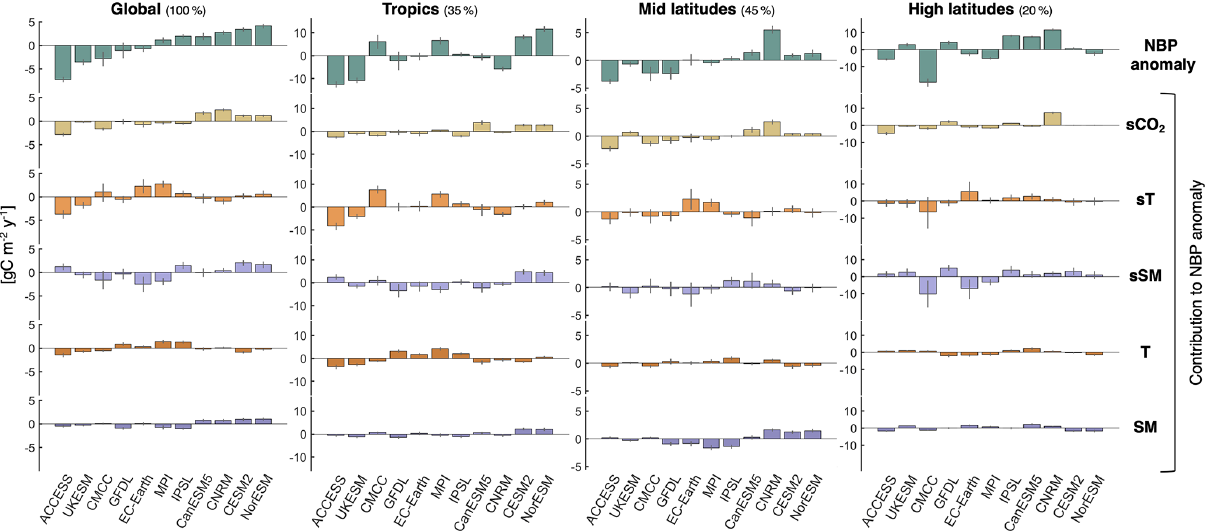
Figure 7. Contributions of the drivers to explaining the anomaly in average projected NBP from individual models relative to the ensemble mean. Estimates are based on the multiple linear regression. Colored bars indicate the mean from the 200 bootstrap samples, while uncertainty bars span from the 5th to the 95th percentile. The spatial average is shown for global land, the tropics (22.5 ◦ S–22.5 ◦ N), mid latitudes (22.5–47.5 ◦ N over North America, 22.5–55 ◦ N over Europe and Asia, and > 22.5 ◦ S), and high latitudes ( > 47.5 ◦ N over North America and > 55 ◦ N over Europe and Asia). The land percentage comprised in each region is noted next to the title: tropics represent 35.1% of the considered global land area, mid latitudes 44.8%, and high latitudes